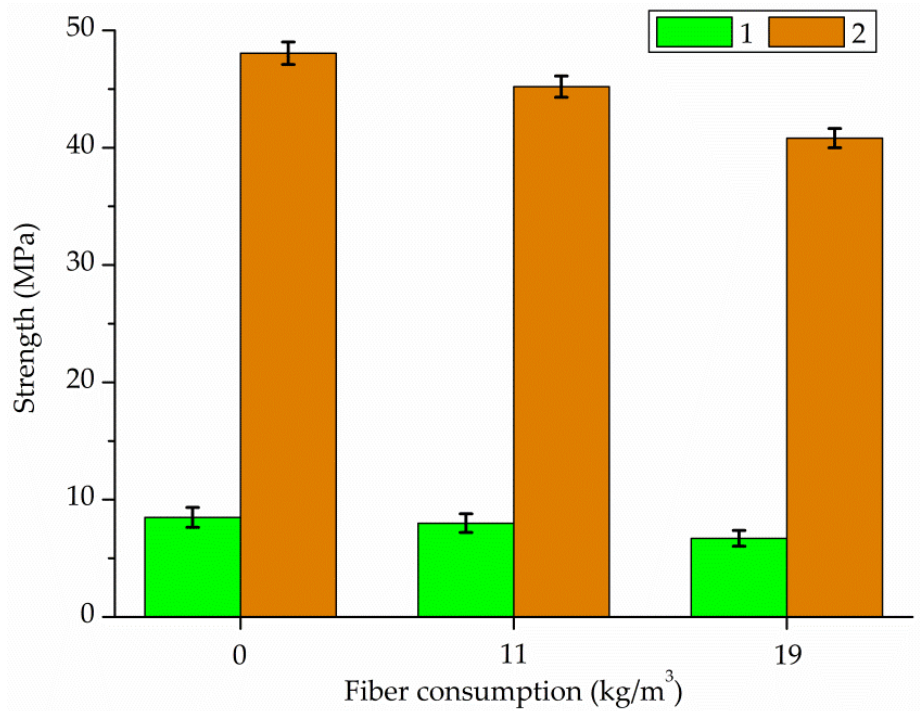
Figure 9. Influence of fiber content on flexural and compressive strengths of concrete: (1) flexural strength and (2) compressive strength.